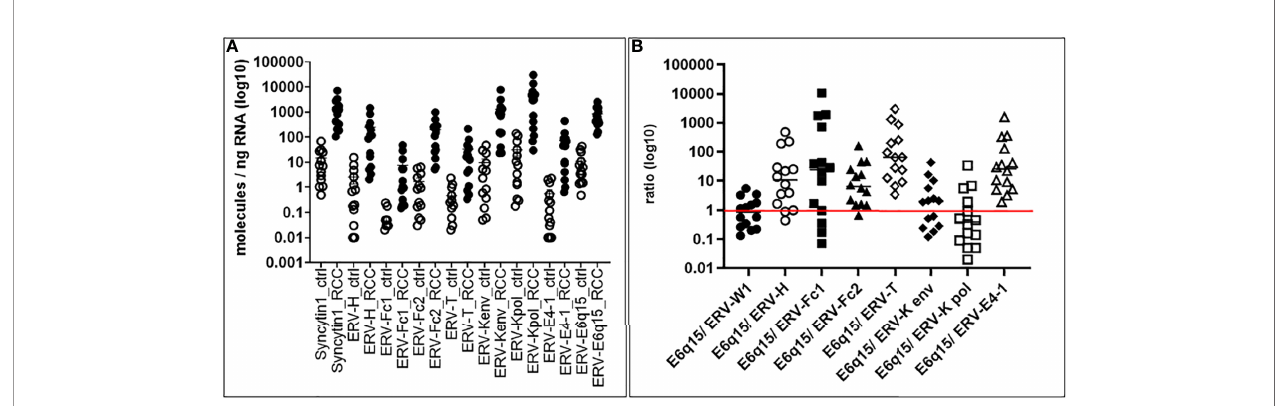
FIGURE 1 | ERV gene expression in primary tissues. (A) ERV expression in ccRCC and control kidney tissues. Seven different ERV gene families were analyzed for expression in molecules/ng RNA (log10) (Y-axis) from 14 primary ccRCC and 11 patient matched tumor associated control tissues (X-axis). Gene expression was then compared using Mann-Whitney two-tailed test, where all ccRCC tumors were signi fi cantly increased compared to controls (p < 0.0001). (B) ERV6q15 env expression ratios in primary ccRCC. The graph shows for each ccRCC (n= 14; same tissues as in A) the speci fi c ERV expression from 7 families (A) in a ratio (log10) (Y-axis) compared with ERV-E6q15 (X-axis -